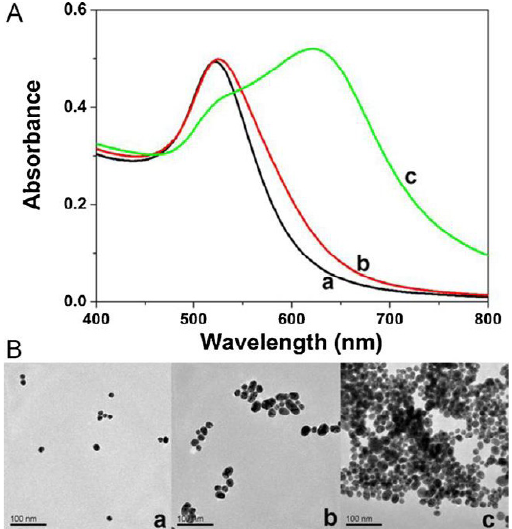
Fig. 8. (A) UV–vis absorption spectra of the citrate-AuNPs (13 nm) (a), P-AuNPs (13 nm) (b) and P-AuNPs (13 nm) in the presence of 20 µ M of Hg 2+ (c). (B) TEM images of the citrate-AuNPs (13 nm) (a), P-AuNPs (13 nm) (b) and P-AuNPs (13 nm) in the presence of 20 µ M of Hg 2+ (c). Reprinted with permission from ref. 76. Copy right 2011